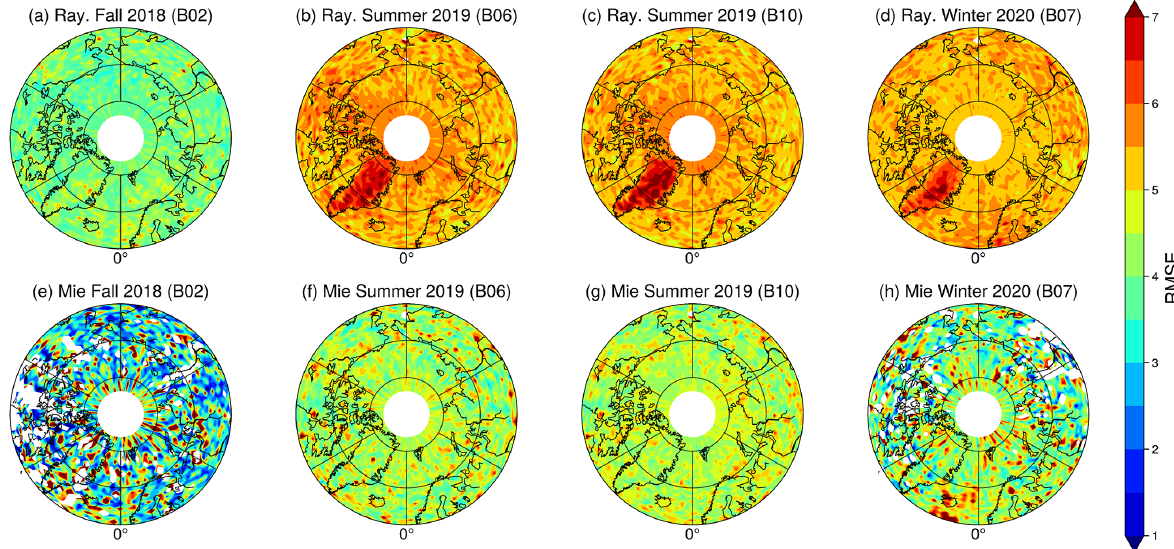
Figure 12. Similar to Fig. 11 but for selected upper-atmospheric regions (Rayleigh U+S and Mie U).